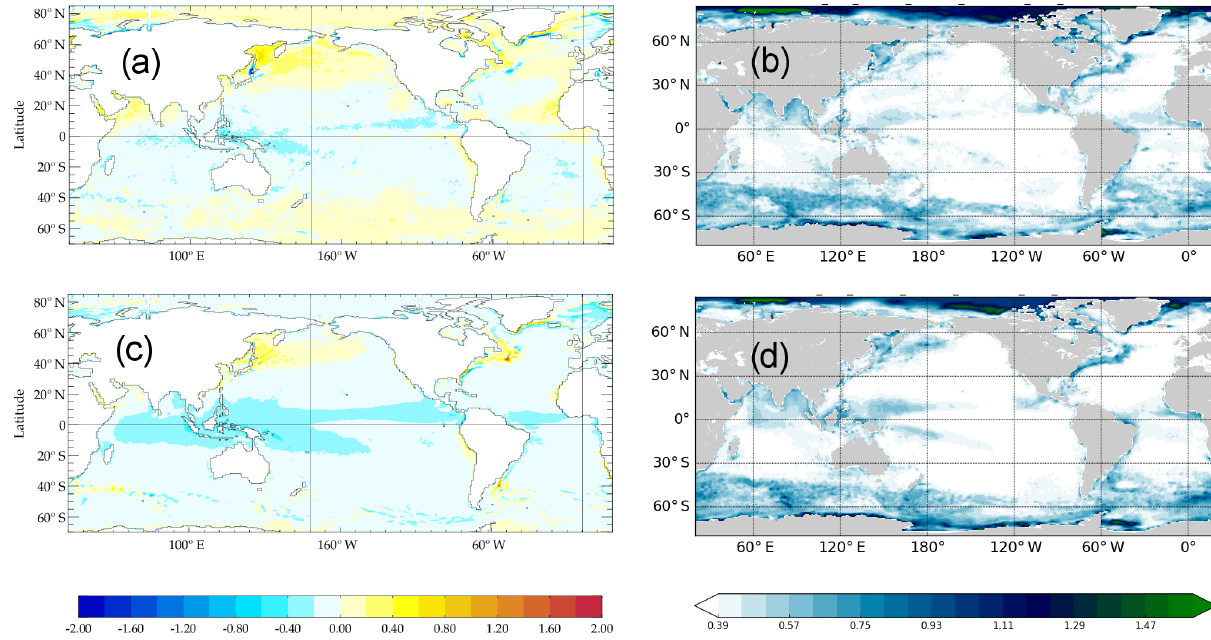
Figure 20. Same as Fig. 18 but for SST from (a, b) HadISST2 and (c, d) OSTIA data sets, as (a, c) mean bias (in K) and (b, d) normalized RMSE with respect to